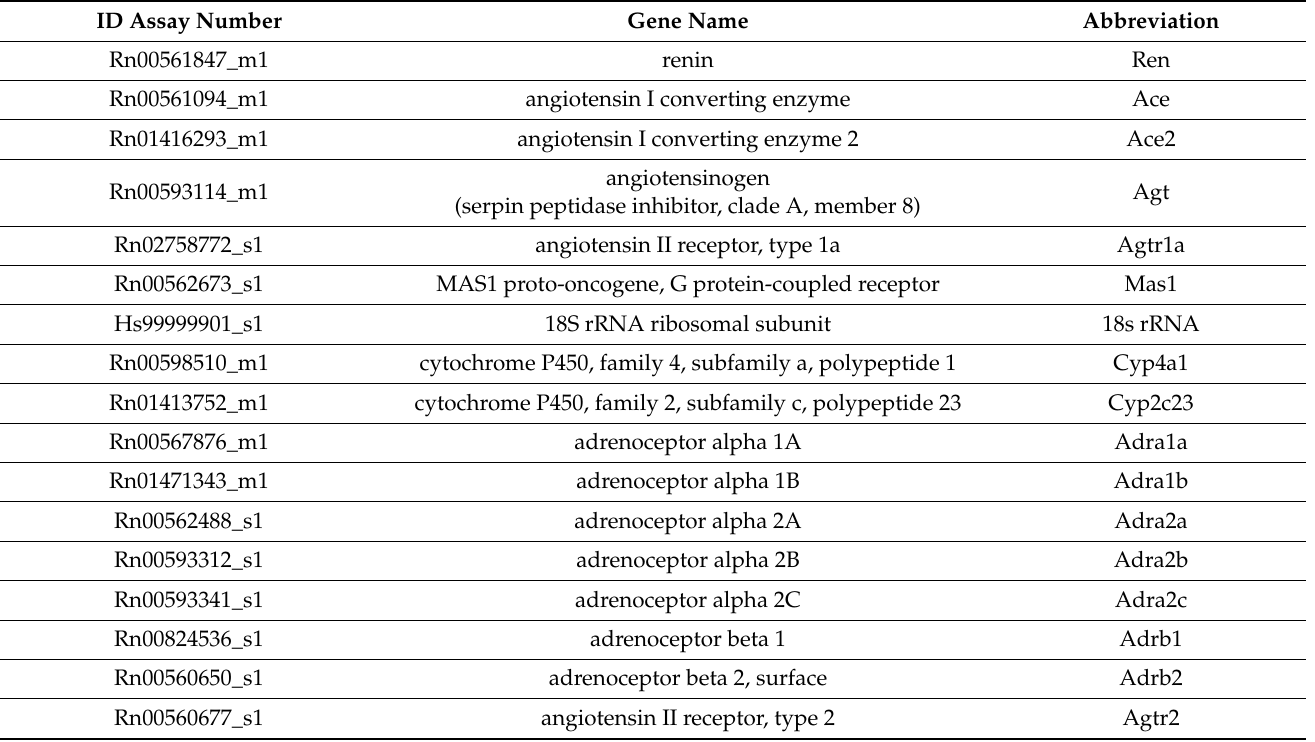
Table 1. Genes analyzed in the kidney